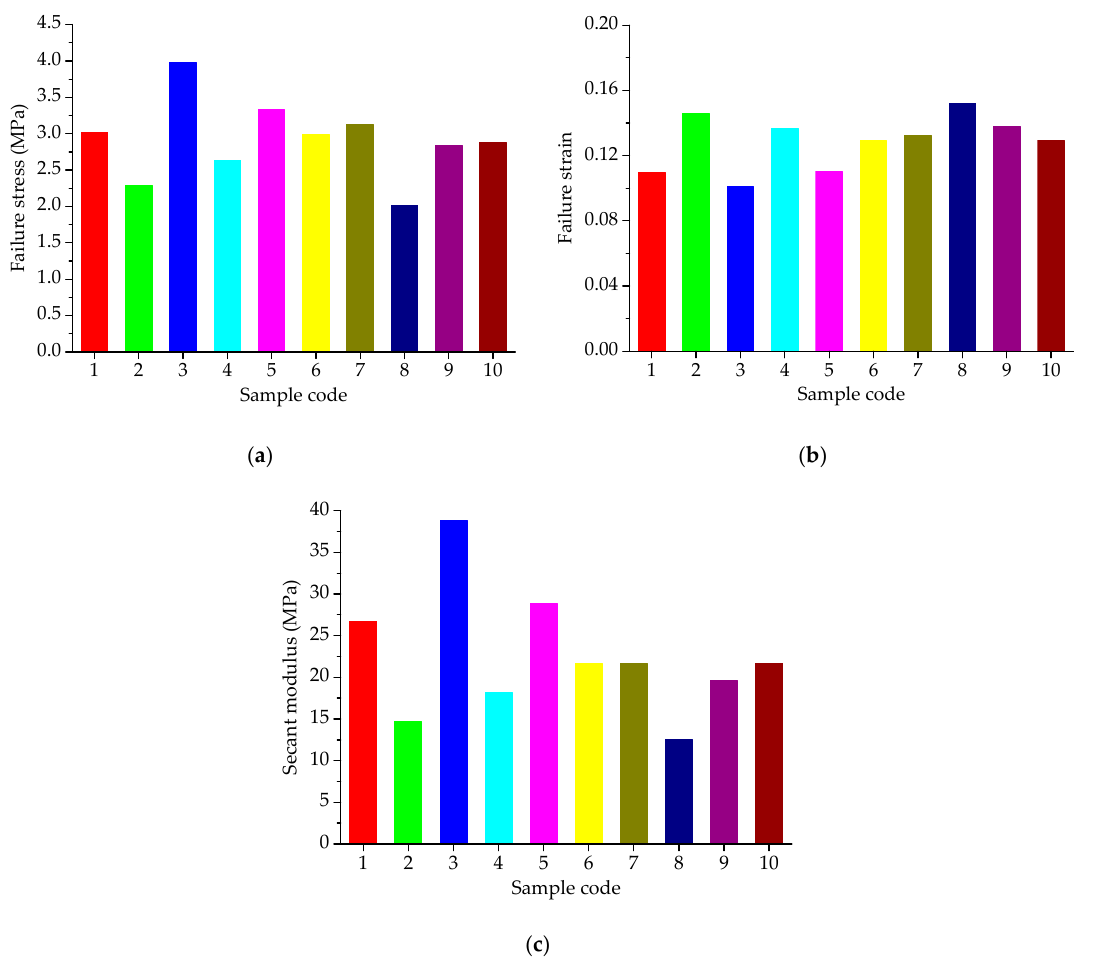
Figure 4. Failure results of asphalt mortars: ( a ) Failure stress; ( b ) Failure strain; ( c ) Secant modulus.